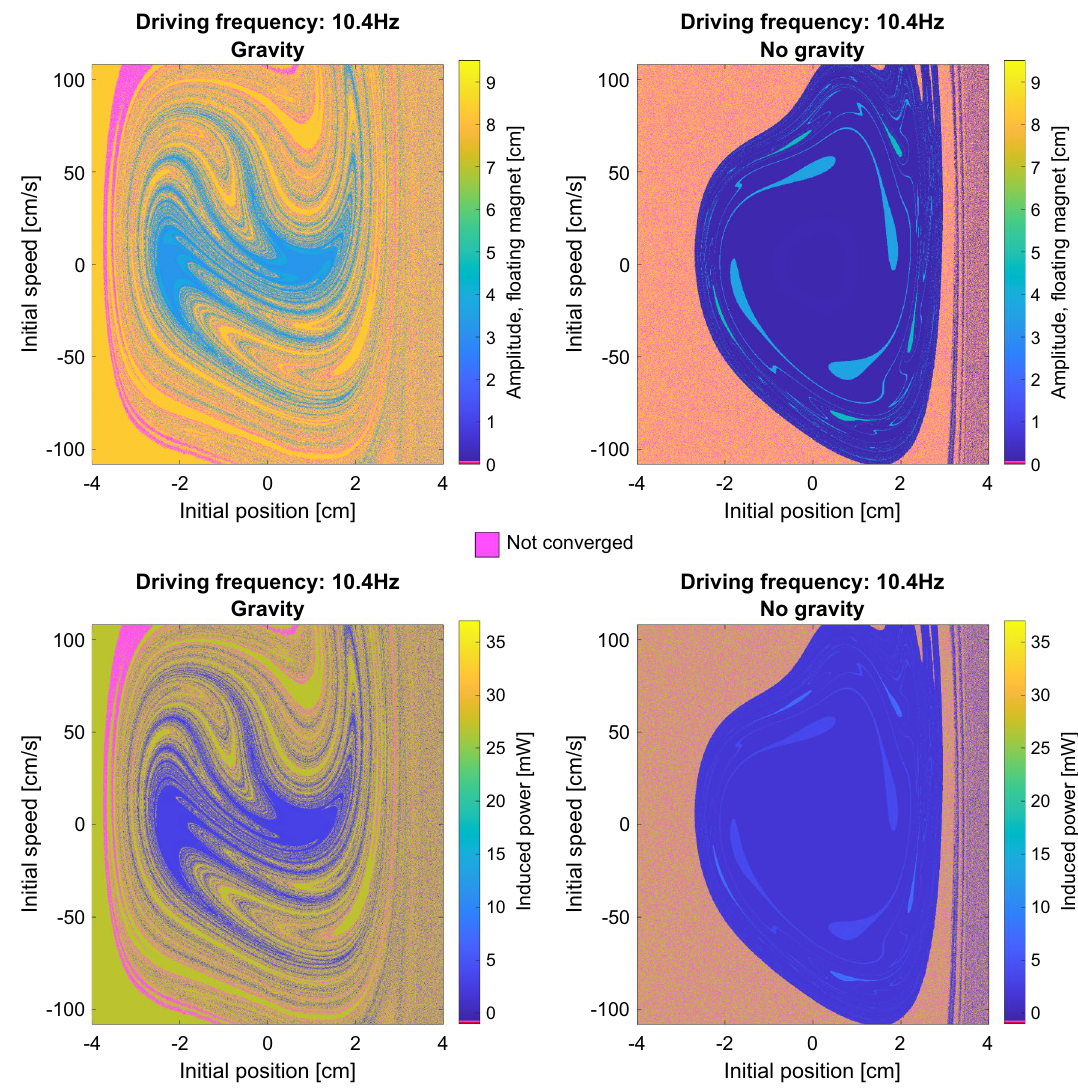
Figure 6. The amplitude of the floating magnet for 10.4 Hz with and without gravity for a range of initial positions and initial speeds and b) the corresponding induced power in the coils. Note that the color pink, which does not appear in the color scale, corresponds to systems that have not converged to a steady state